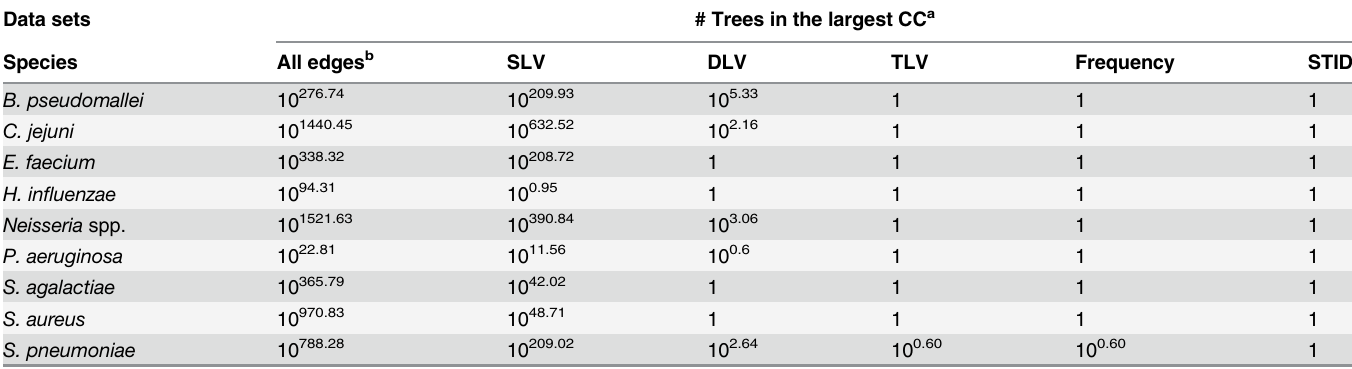
final tree according to a set of well defined rules that guarantee the uniqueness and consistency of the selected tree, independently of the input order of the nodes [9, 21]. The impact of the ap- plication of each of the rules on the space of possible trees for the largest CC of each species is presented in Table 2. For most species, a single tree is obtained when applying up to the second tiebreak rule (higher number of DLVs), but in the case of B. pseudomallei, C. jejuni and Neis- seria spp. a single tree is only obtained when invoking rules up to the third tiebreak rule (higher number of TLVs). In the case of S. pneumoniae only the last tiebreak rule (higher number of STID) results in a single tree. Large reductions in the available tree space can be seen with the application of each goeBURST rule and this can be used to evaluate the impact of each rule on the final phylogenetic hypothesis proposed by the algorithm. The magnitude of the reduction of tree space varies between the species considered (Table 2). It is clear that the number of STs influences the number of possible trees, with the